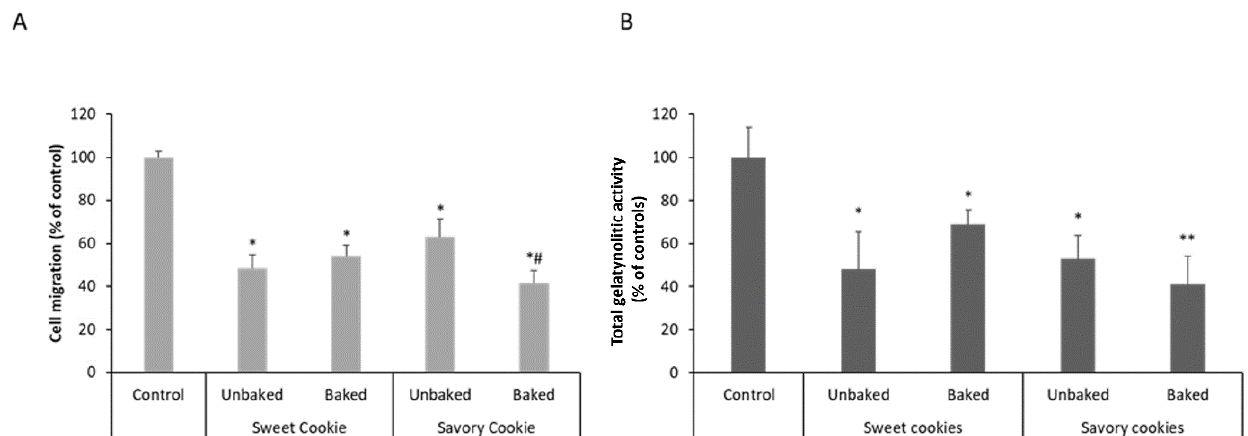
Figure 2. LPC bioactivity in wheat cookies against ( A ) colon cancer cell migration and ( B ) MMP-9 activity. Sweet and savory cookies were tested, both baked and unbaked dough. Data are expressed as the means ± SD. (* p < 0.05, ** p < 0.001 when compared to control; # p < 0.05 when compared to unbaked savory cookie).